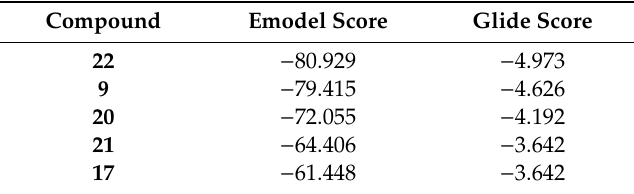
Table 4. The scoring values for compounds 9 , 17 , and 20 – 22 .